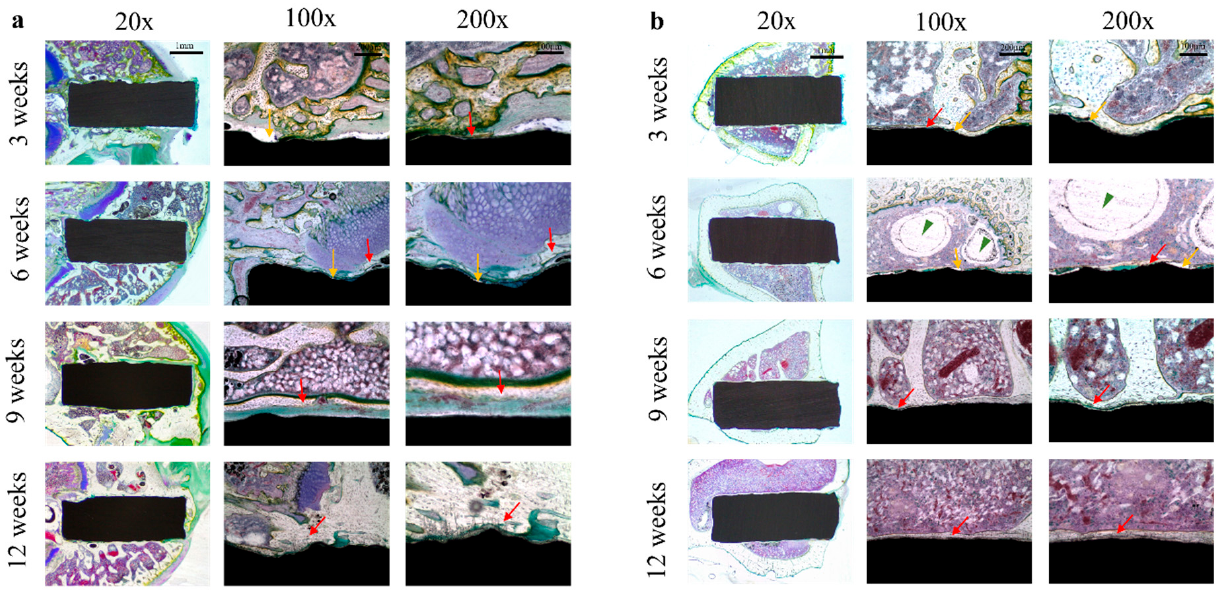
Figure 5. Histological images postoperatively (by Villanueva bone stain) at 3, 6, 9, and 12 weeks. ( a ) Distal femoral epiphysis, ( b ) tibial diaphysis. The red arrows indicate newly formed osteocytes, the yellow arrows indicate the gap between new bone layers and implant surface, and the gas pockets are marked as green arrowheads.